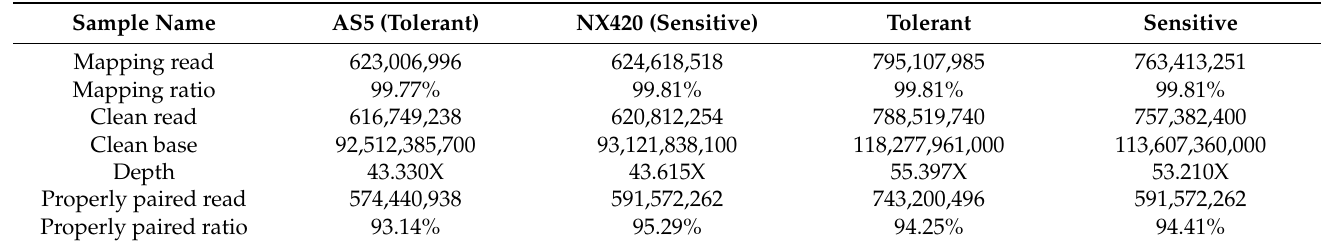
Table 1. Coverage of the reads mapping to the B73 reference genome from the re-sequencing of AS5 and NX420 using BGI.